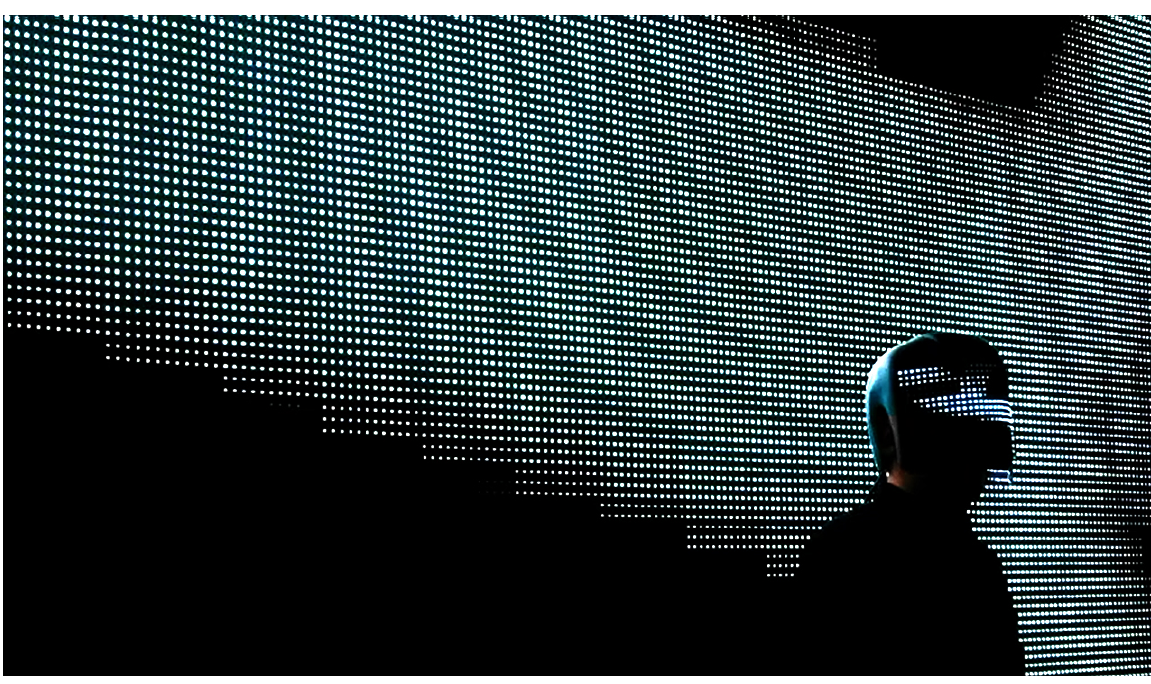
FIGURE 4 | Squarepusher Live Audiovisual performance